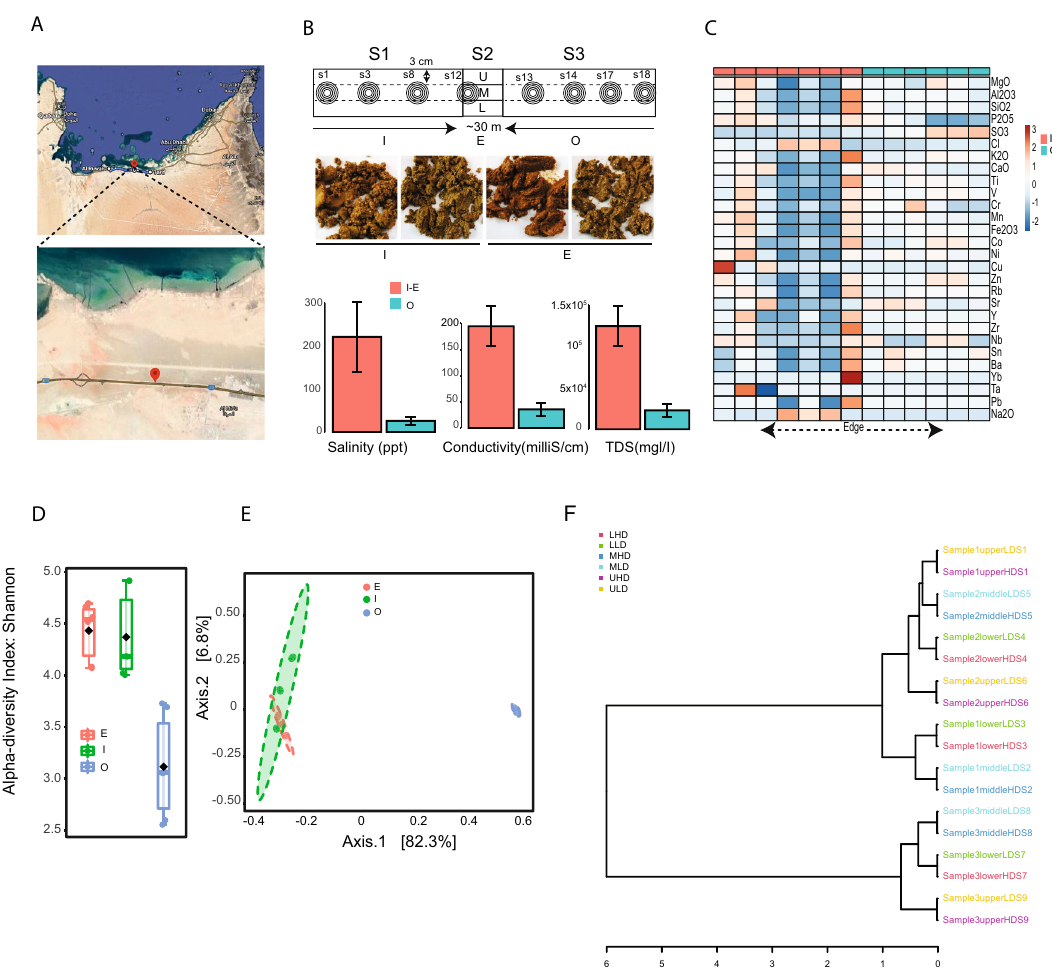
Figure 1. Sampling design, mineral, and 16S diversity analysis. ( A ) Sampling sites for coastal sabkha at Al Mirfa Abu Dhabi (UAE) (top panel). A zoom on the sampling site is shown (below panel), where you see the color difference of salt to sand of coastal sabkha. ( B ) Schematic drawing of the intersection of salt and sand in a coastal sabkha (top panel). Sampled 16S regions are S1 (inner), S2 (edge) and S3 (outer) sabkha. The sampling was done in duplicates at a 3 cm depth, where the core sample was divided, as high (upper layer), middle (middle layer) and bottom (lower layer). For whole metagenome, sampling was done in a 0.5 m interval from the edge (3 m length), starting with s12, then s8, s3, s1 toward the inner sabkha defined as (I–E). Similarly, this was done toward the outside with 0.5 m interval with s13, s14, s17, and s18 and defined as (O). A picture of different samples collected, which shows the copper enriched samples on the inside to edge (middle panel). The lower panel depicts the difference in salinity between inside and outside. ( C ) Heatmap of the different minerals in sabkha from inside to outside. Color band represent logarithm values. ( D ) Shannon diversity index for inner and outer sabkha. ( E ) Bray–Curtis beta diversity presented as a principal component for inner and outer sabkha. ( F ) Dendrogram showing the clustering of samples (Sample 1: inner; Sample 2: edge and Sample 3: